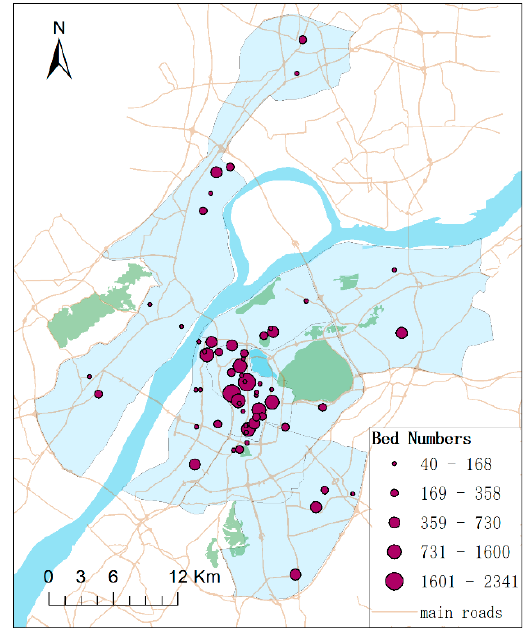
Figure 2. Healthcare service facilities in the study area. Figure 3. Population in the study area. ISPRS Int. J. Geo-Inf. 2019 , 8 , x FOR PEER REVIEW